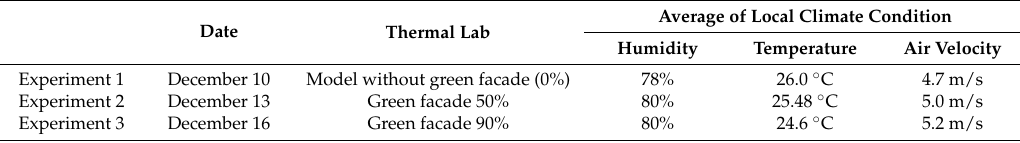
Table 3. Configuration of the green facade in each